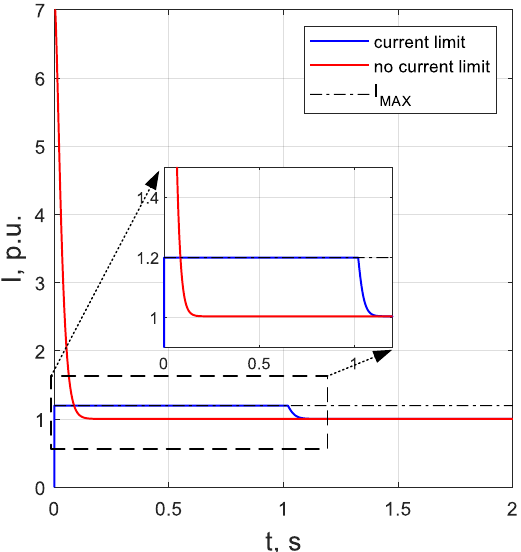
Figure 5. Current amplitude for different systems with same initial operation point ( 0.2π, 0 ), red curve: without current limitation; blue curve: with current limitation.